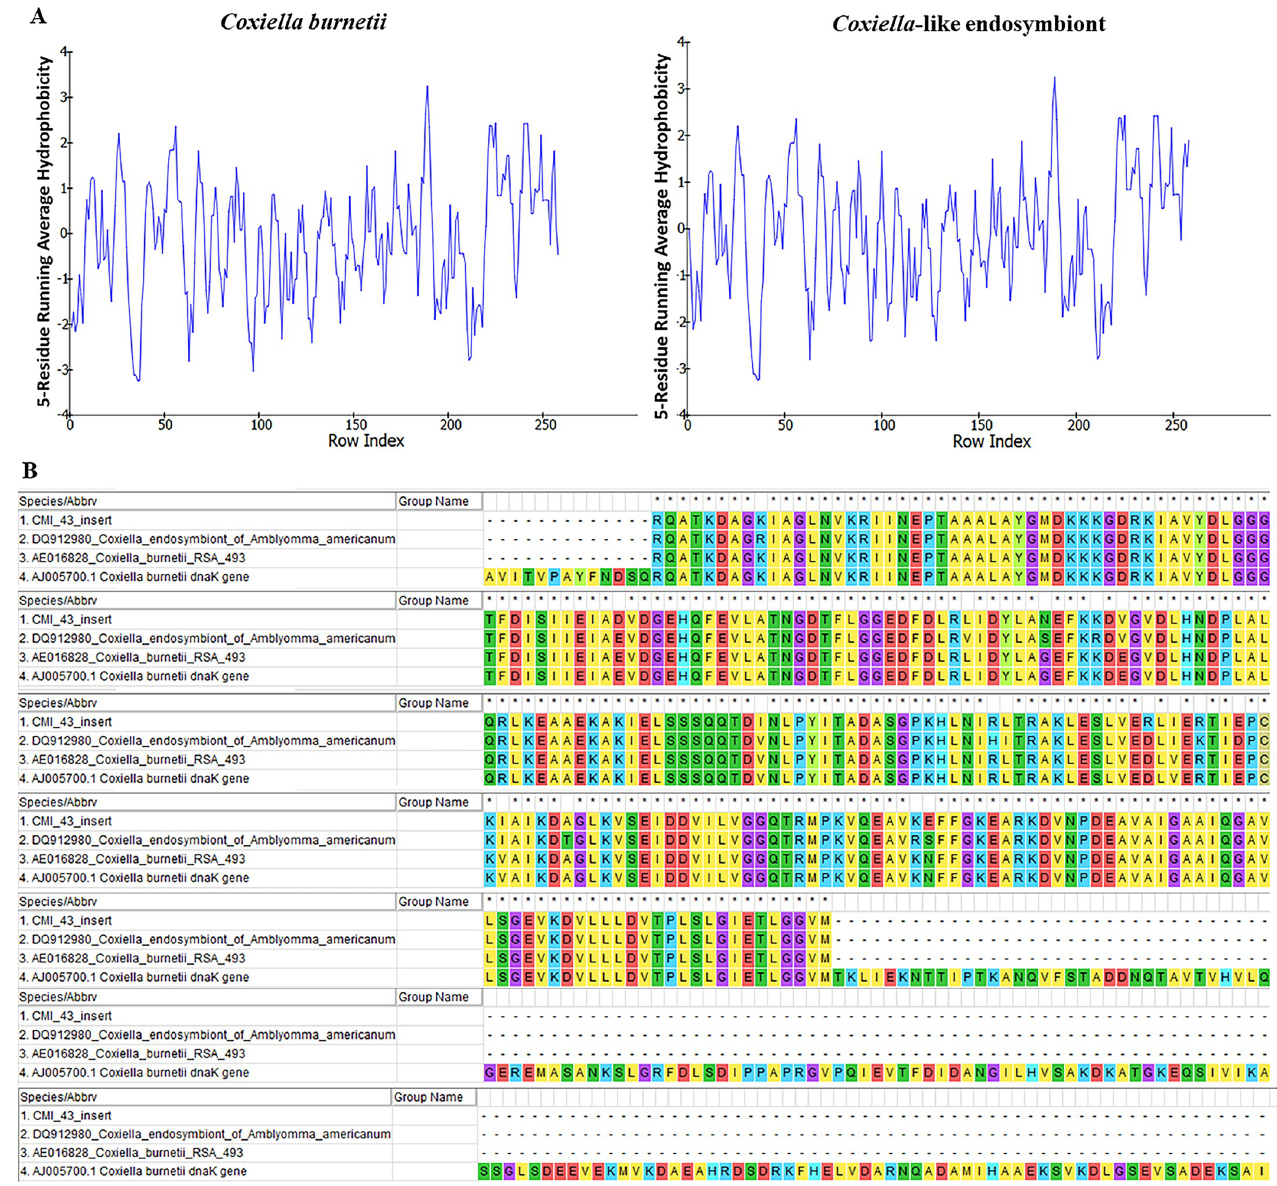
Fig 8. Comparison of hydrophobicity of the partial DnaK protein and comparison of amino acid sequences of expressed DnaK proteins of Coxiella sp. (A) Hydrophobicity of partial DnaK proteins of C . burnetii and CLE from R . annulatus . (B) Comparison of expressed partial DnaK protein of CLE from R . annulatus (1), translated amino acids of CLE from A . americanum (2) and expressed partial DnaK protein of C . burnetii RSA 493 (3,4).